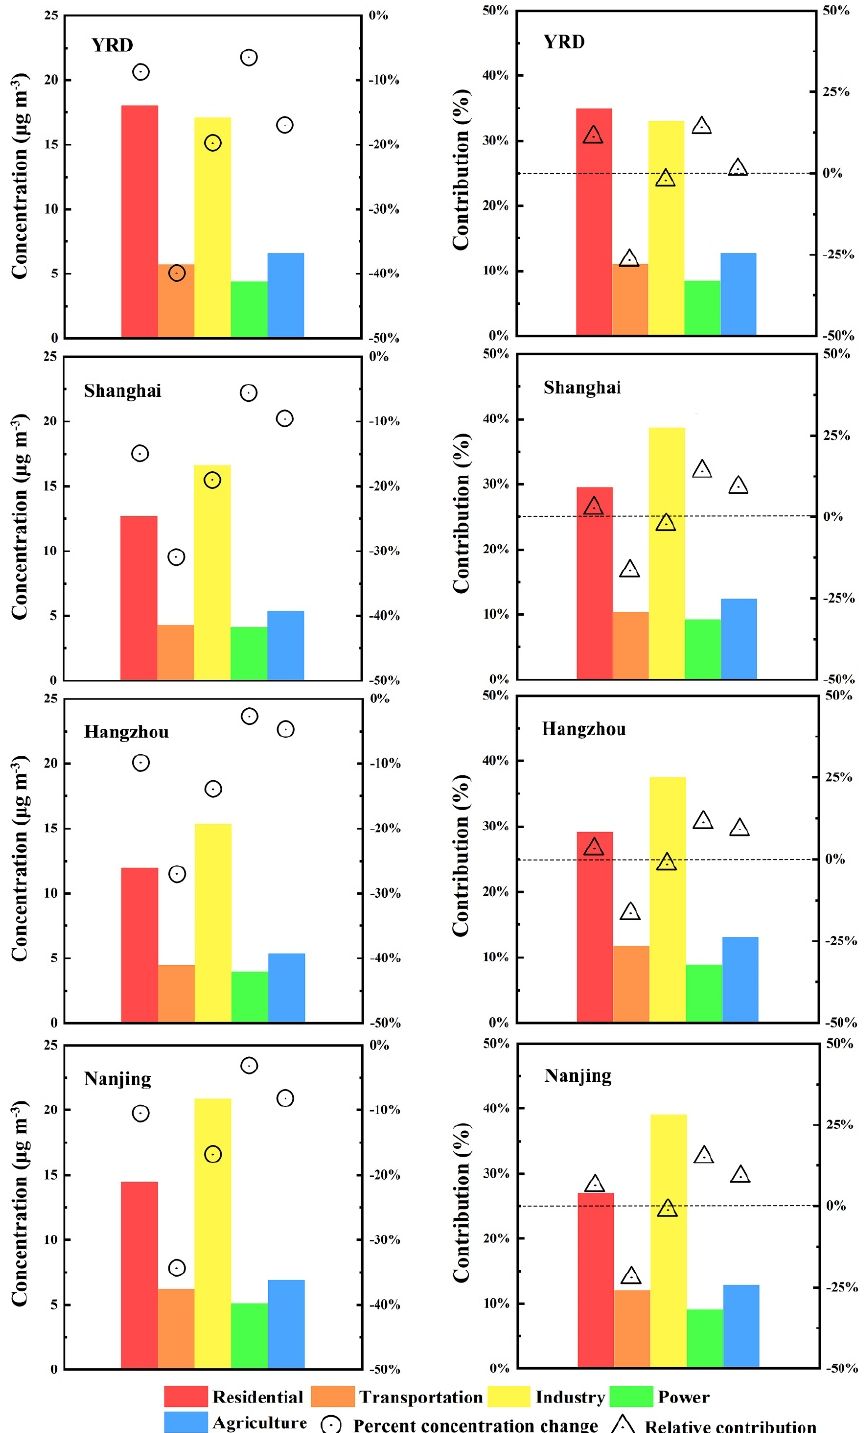
Figure 5. Concentrations and contributions of different emission sectors to PM 2 . 5 in the YRD and three major cities in case 2 from 23 January to 28 February 2020. The values of the histograms correspond to the left y axis and the values of relative changes correspond to the right y axis. The relative contribution means the relative change in contribution between case 1 and case 2, calculated as (case 2 − case 1) / case 1. The percent concentration change means the relative change in concentration, calculated as (case 2 − case 1) / case